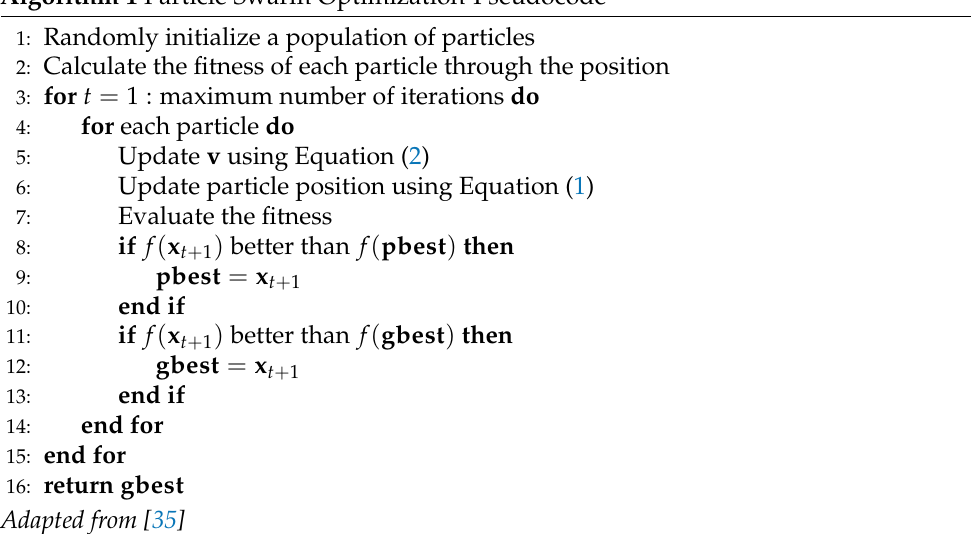
Algorithm 1 Particle Swarm